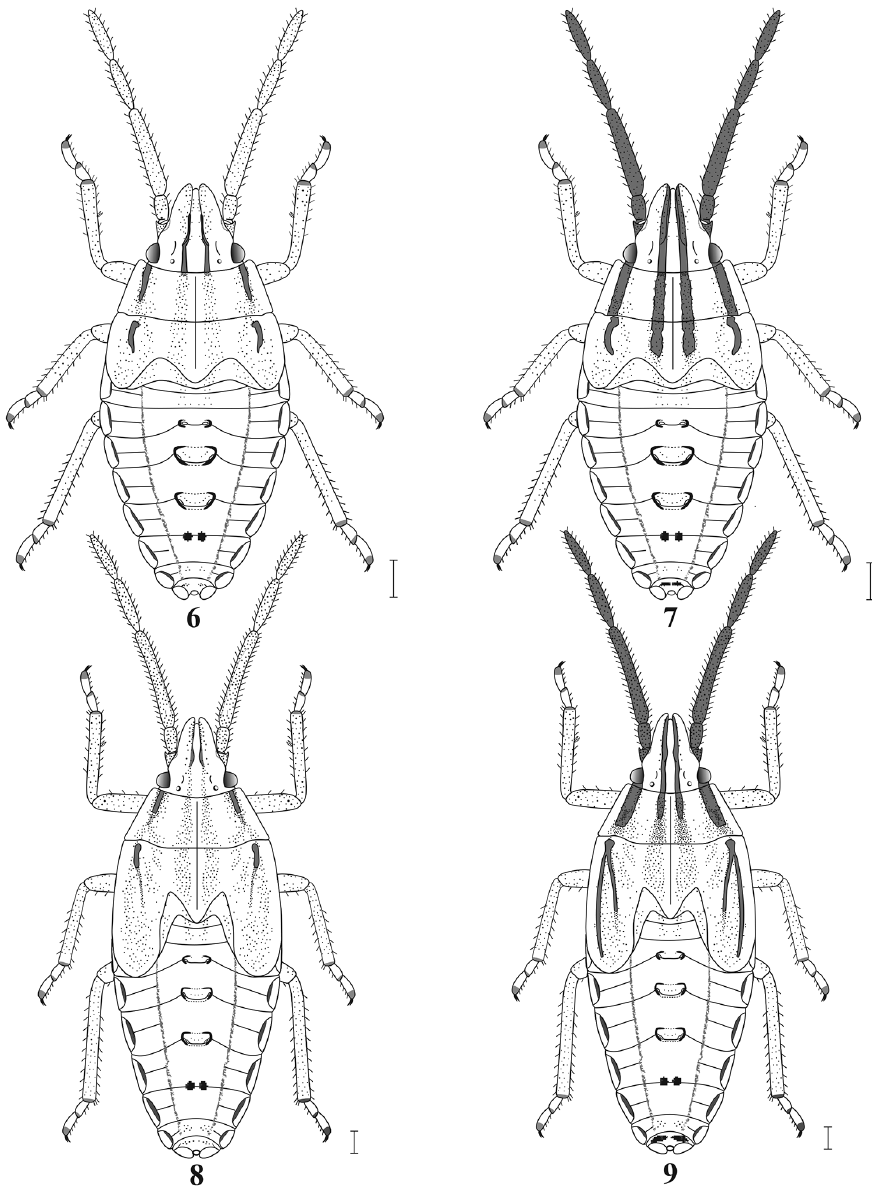
Figures 6–9. 6 Fourth instar of M. major , light form (dorsal view) 7 Fourth instar of M. major , dark form (dorsal view) 8 Fifth instar of M. major , light form (dorsal view) 9 Fifth instar of M. major , dark form (dorsal view) Scale bars: 0.5